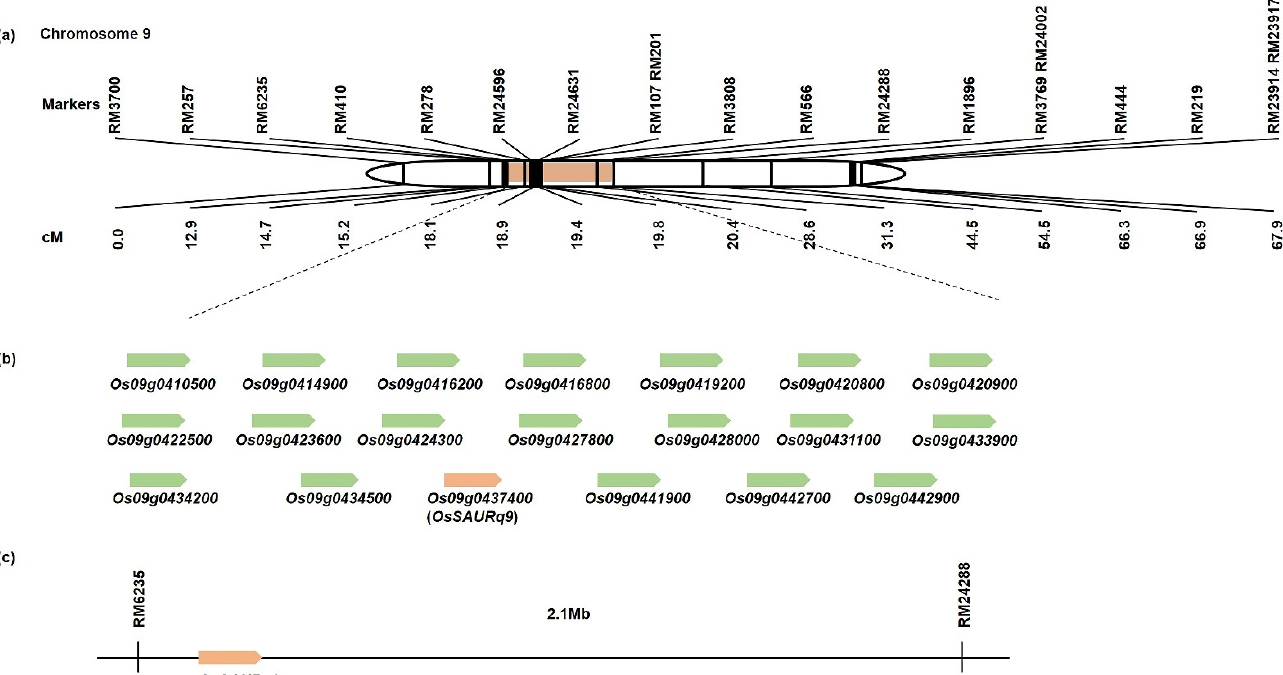
Figure 5. Comparison between the 20 selected tiller angle-related genes by QTL analysis and the relative expression levels of six tiller angle-related genes that have already been reported. The expression of tiller angle-related genes in Cheongcheong, Nagdong, compact type (CNDH 52-2, CNDH 57, CNDH 103-2, CNDH 104, and CNDH 105), and spreading type (CNDH 25, CNDH 26, CNDH 38, CNDH49, and CNDH64). Values are the means ± SD (n = 3). Stars on each bar represent the significant difference at (*) p < 0.05, and (**) p < 0.01 (two-tailed Student’s t -test).